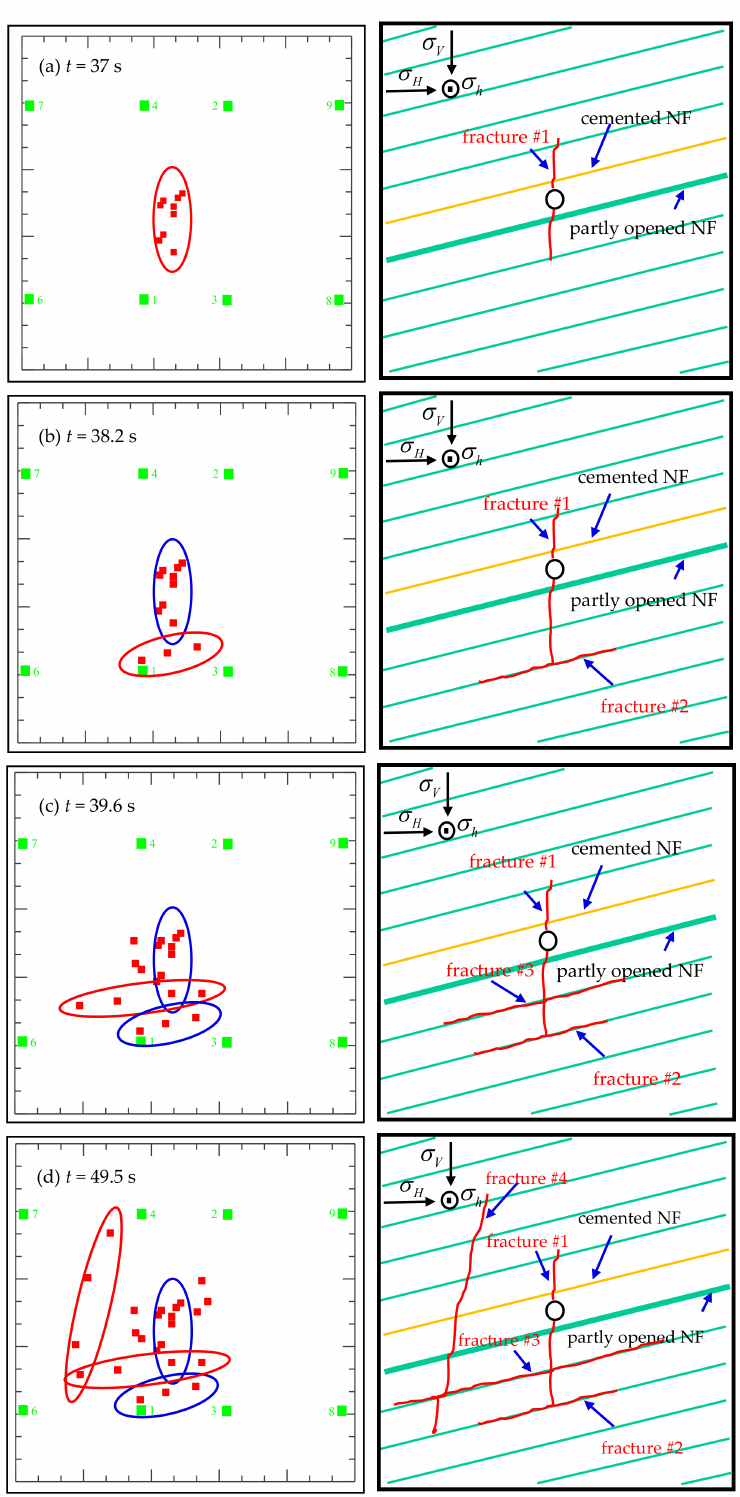
Figure 21. AE detection results for specimen Y-7-1 after conducting